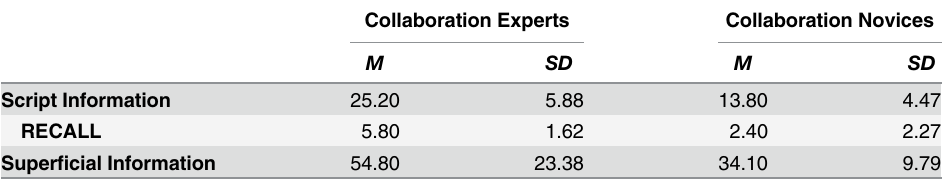
Table 3. Descriptive Statistics of Study 1. Scores represent the number of the information type stated over all the stimuli for both conditions. RECALL is the number of script information deployed after recall